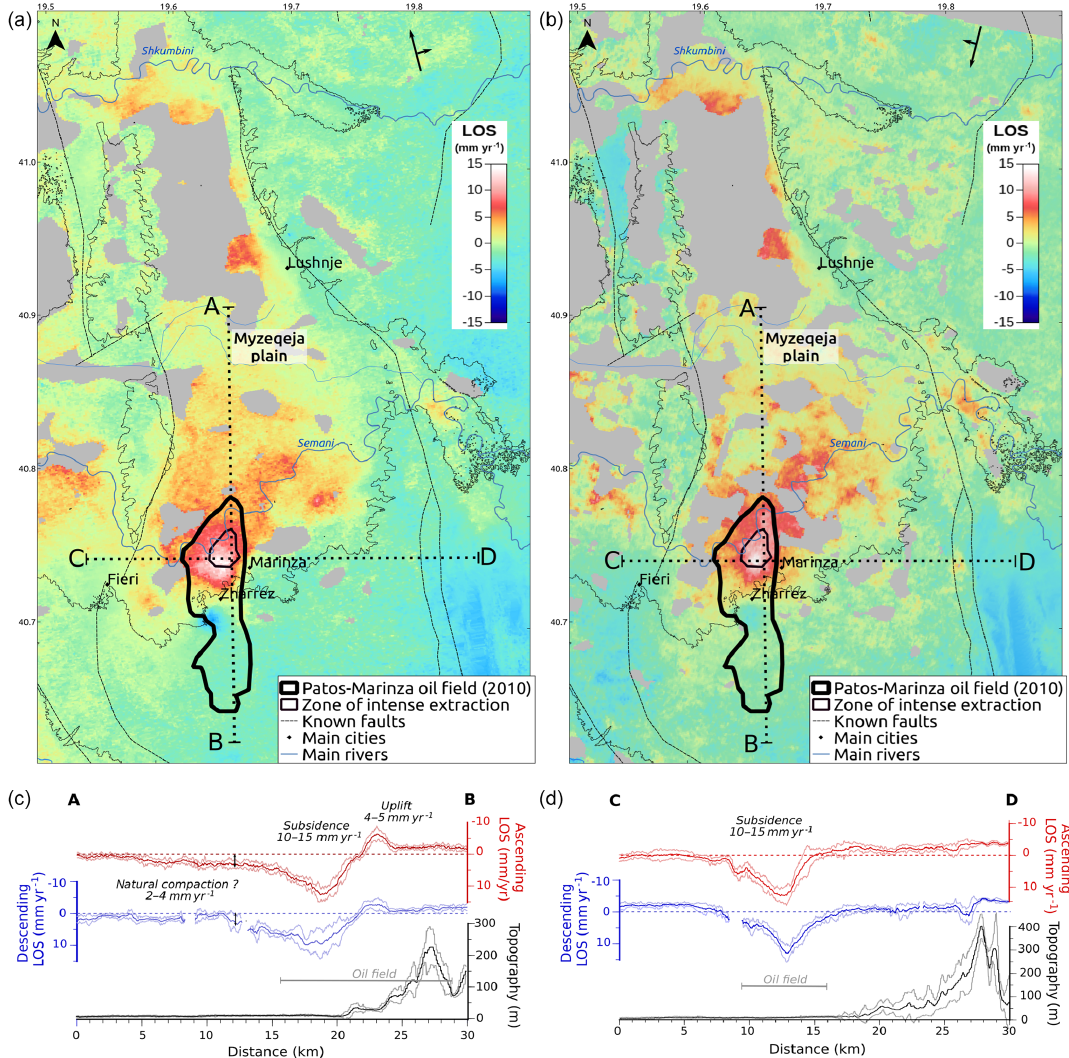
Figure 6. (a, b) Zoomed-in view of the LOS average velocity map for the ascending (a) and descending (b) tracks over the Patos-Marinza oil field. Color code and sign convention are the same as in Fig. 5. Dotted lines indicate the location of the profiles in (c, d) . (c, d) North–south (c) and west–east (d) velocity profiles across the oil field’s most intense deformation zone together with topography profiles (c, d) . Average values over a 2km width across the profile lines are plotted darker, while lighter lines limit the 2 σ standard deviation